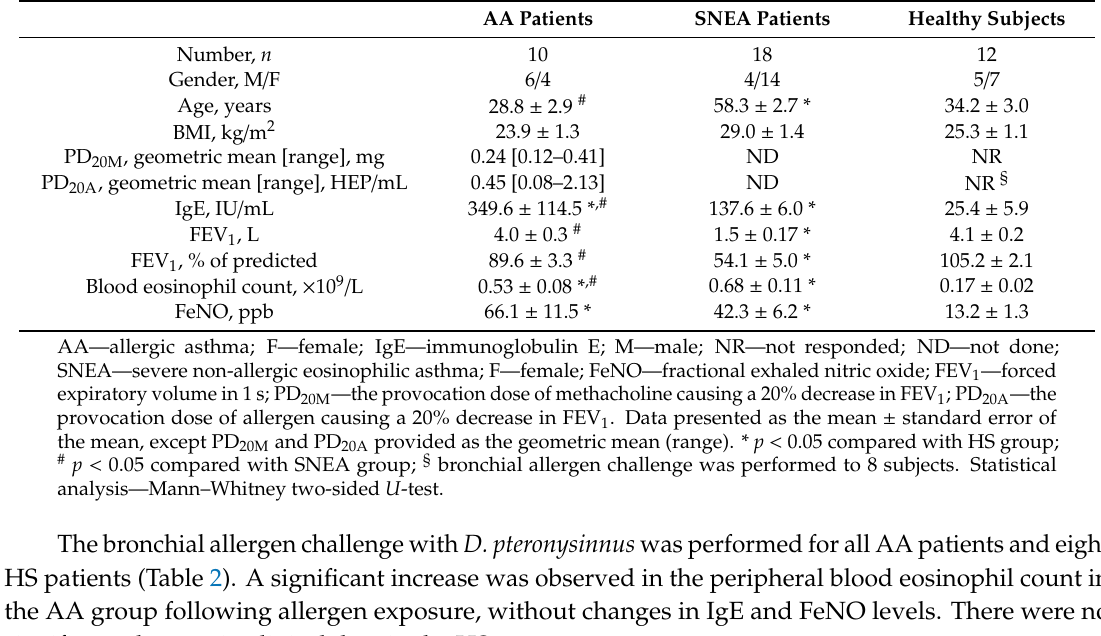
Table 1. Demographic and clinical characteristics of the study